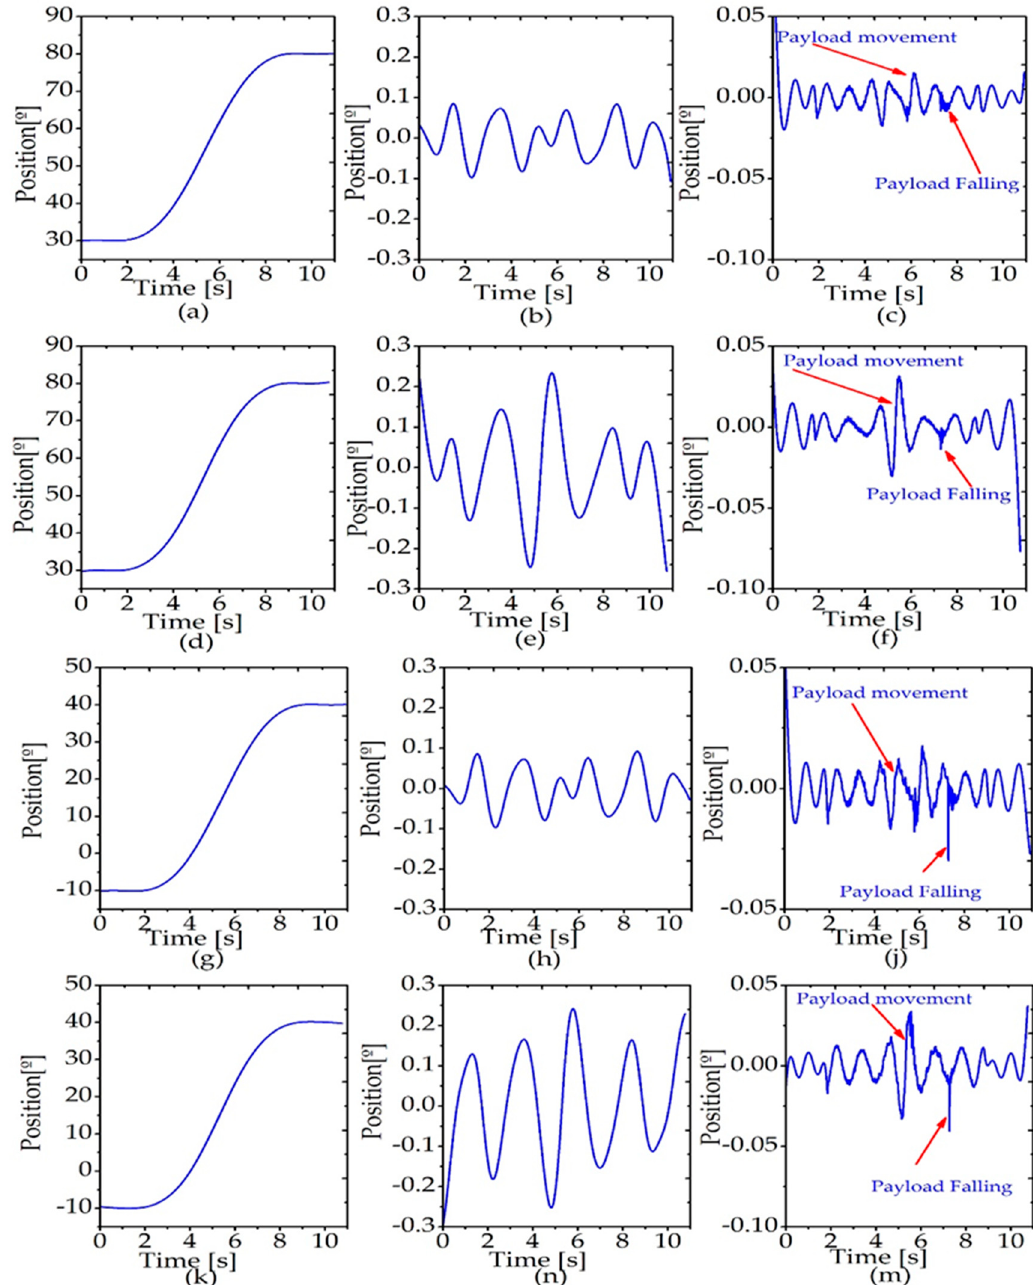
Figure 15. The position of the encoder signal decomposition outcomes in joint 1 and joint 2 at two speeds with payload 4 kg containing Case 1: ( a ) Trend in joint 1 at speed 6°/s, ( b ) oscillations in joint 1 at 6°/s ( c ) residual in joint 1 at 6°/s, Case 2: ( d ) Trend in joint 1 at 12°/s, ( e ) oscillations in joint 1 at 12°/s, ( f ) the residual in joint 1 at 12°/s, Case 3: ( g ) Trend in joint 2 at 6°/s, ( h ) oscillations in joint 2 at 6°/s, ( j ) residual in joint 2 at 6°/s, Case 4: ( k ) Trend in joint 2 at 12°/s, ( n ) oscillations in joint 2 at 12°/s ( m ) residual in joint 2 at 12°/s.